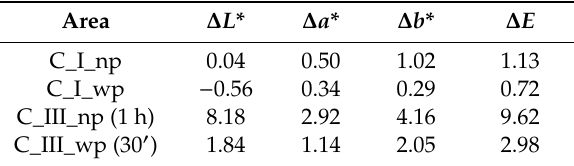
Figure 7. Optical images at 10 × of mock-up C treated with propylene carbonate ( a , c ) on both unprotected and protected area, and with Nanorestore Gel ® ( b , d ) applied for 1 h and 30 min on the unprotected (np) and the protected (wp) area respectively. ( a ) C_I_np; ( b ) C_III_np; ( c ) C_I_wp; ( d ) C_III_wp. Table 4. Colorimetric measurements on unprotected and protected areas after the cleaning procedure I and